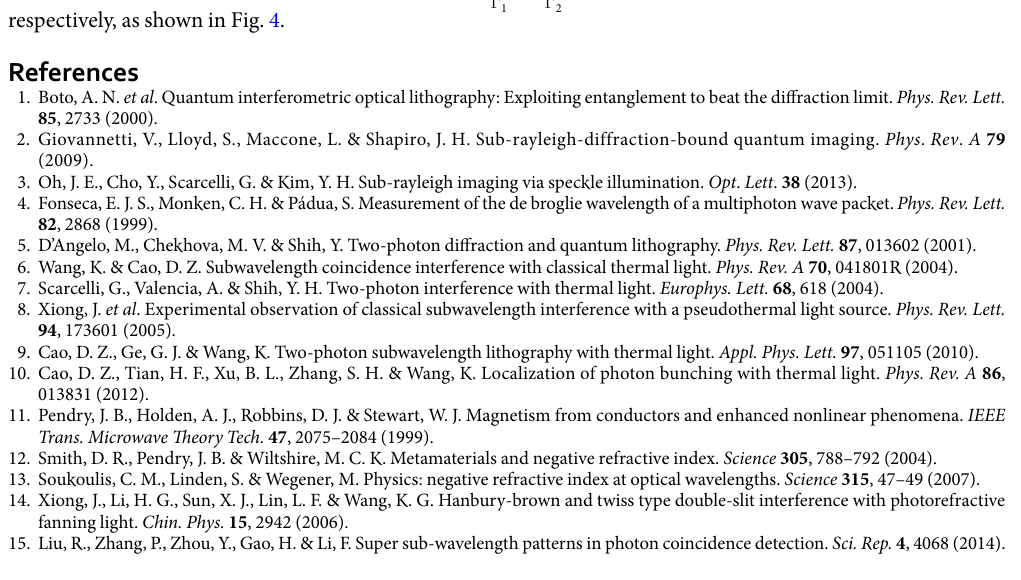
respectively, as shown in Fig.